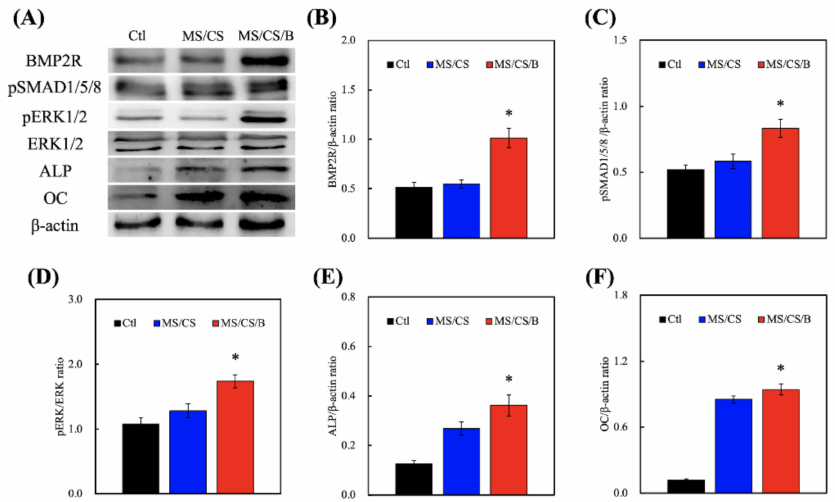
Figure 7. ( A ) Immunodetection of anti-bone morphogenetic protein receptor type II (BMP2R), anti- extracellular signal-regulated kinase 1/2 (ERK 1/2), anti-phospho extracellular signal-regulated kinase 1/2 (p-ERK 1/2), alkaline phosphatase (ALP), osteocalcin (OC), and β -actin protein expres- sion in hDPSCs cultured on scaffolds for 3 days. Quantification of ( B ) BMP2R, ( C ) anti-phospho SMAD1/5/8 (p-SMAD1/5/8), ( D ) p-ERK 1/2, ( E ) ALP, and ( F ) OC. * indicates a significant difference ( p < 0.05) when compared to